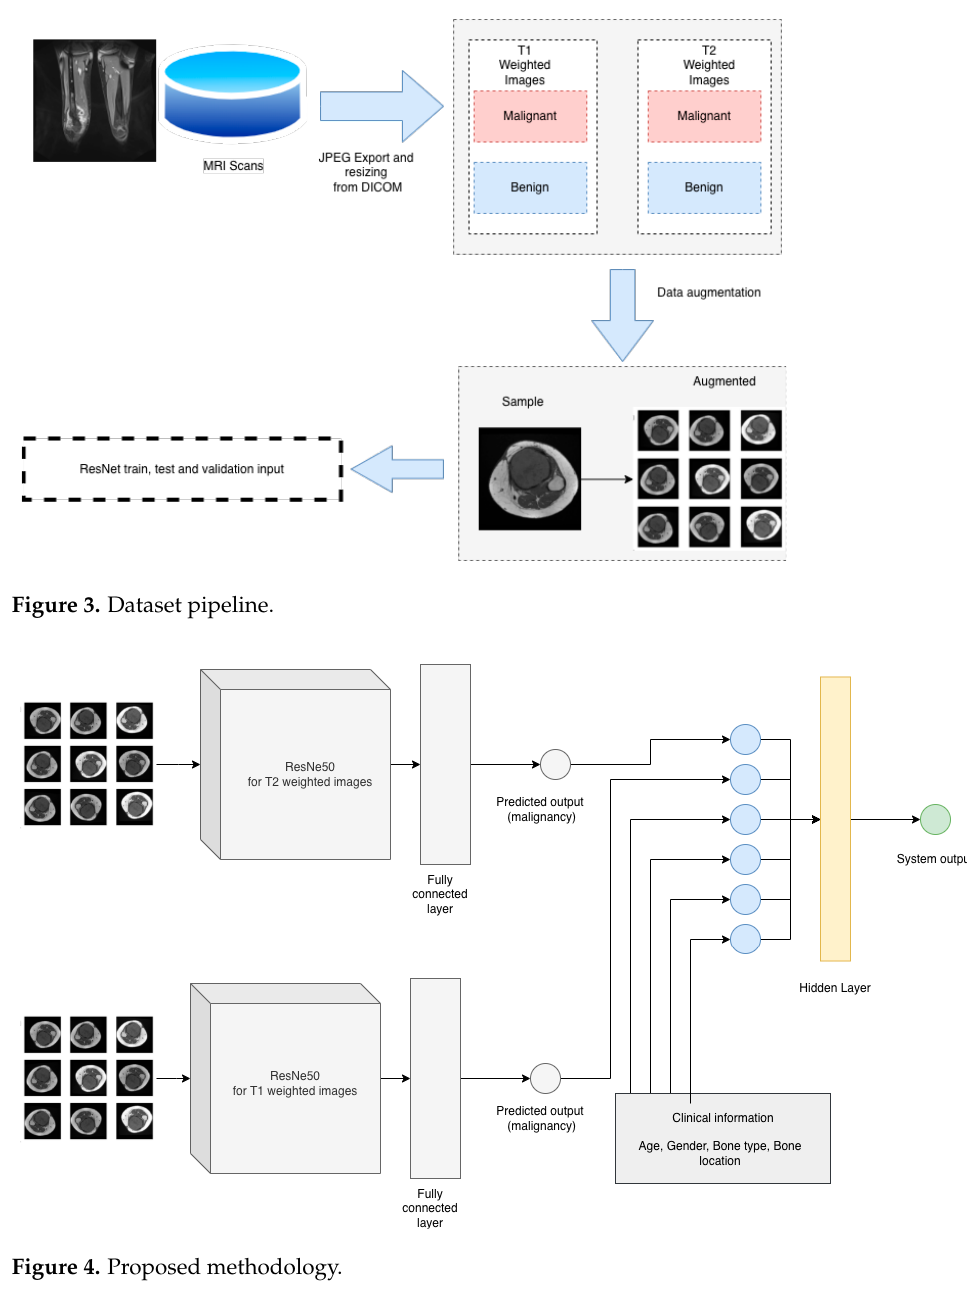
Figure 4. Proposed methodology.